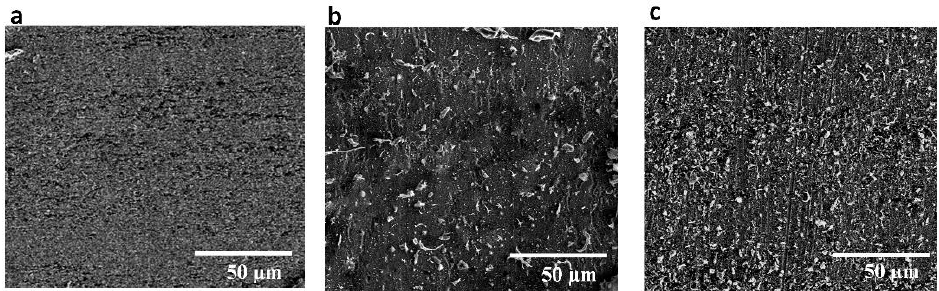
Figure 8. ( a ) SEM image (1000×) for laser-chemical treated surfaces before scratch test. SEM images